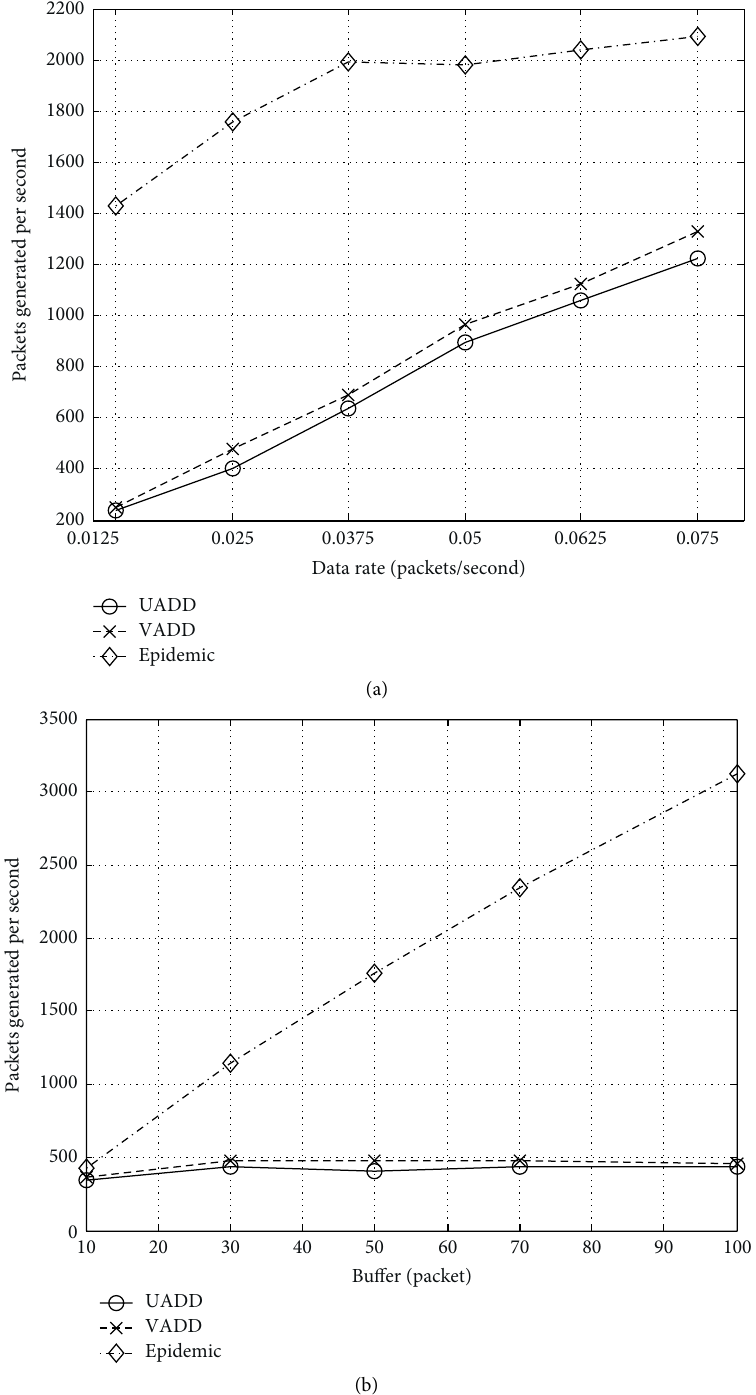
Figure 10: Data traffic overhead of routing protocols. (a) Data traffic overhead vs. data rate. (b) Data traffic overhead vs. packet